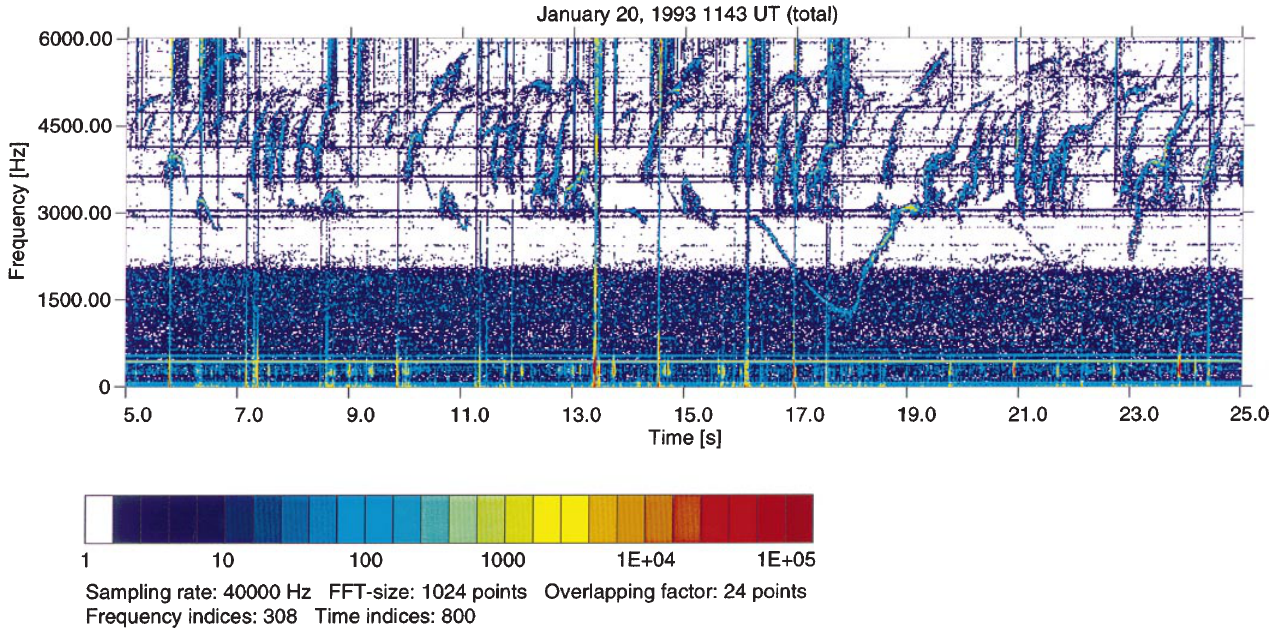
Fig. 3. Numerous emissions triggered by pairs of PLHR at 600 Hz intervals. The doublet 2950/3050 Hz triggers short hooks and a pronounced slow upward hook. The 3-5-5.5 kHz band contains numerous steep triggered